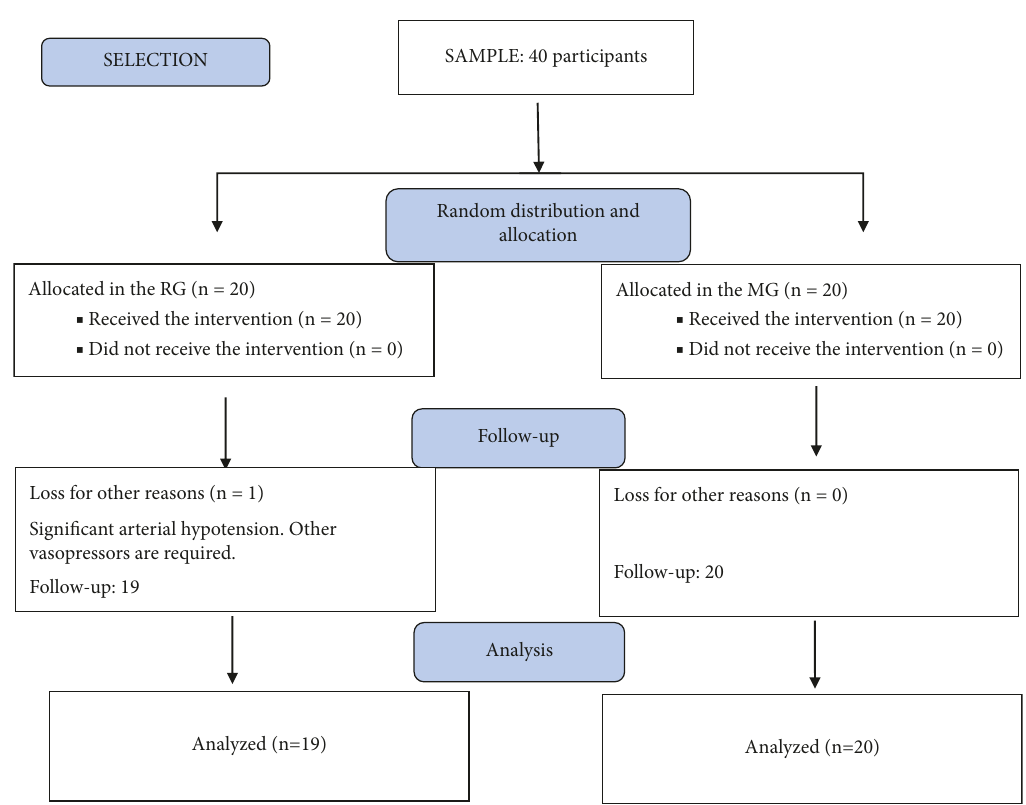
Figure 1: Consort flowchart. RG, remifentanil group; MG, magnesium sulfate